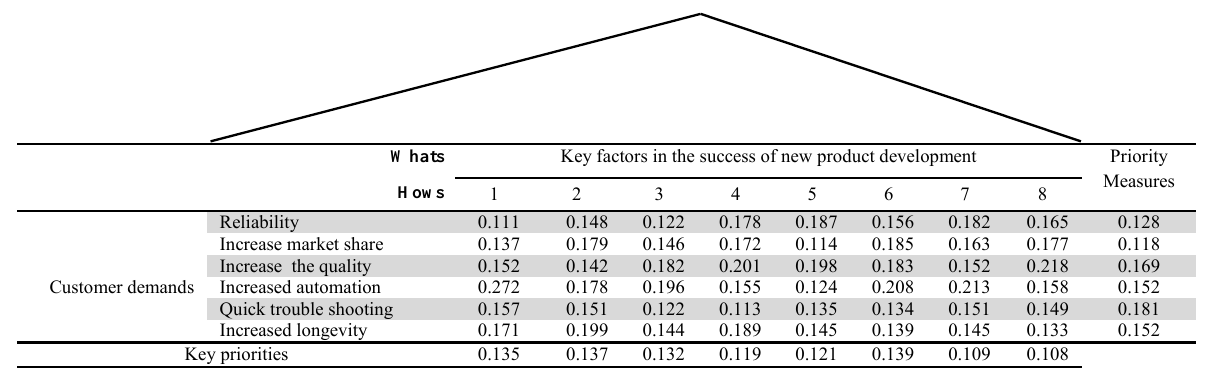
Fig. 1. The results of house of quality